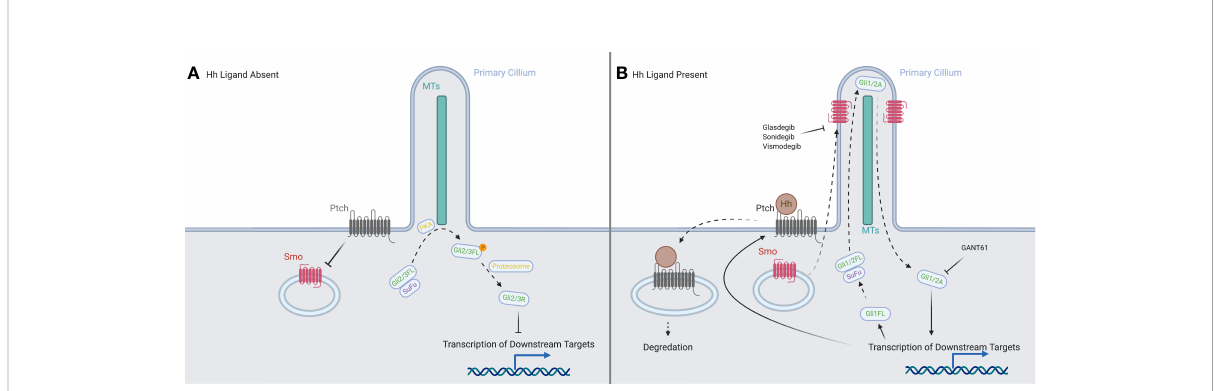
processed into their repressor forms, which inhibit downstream transcription. (B) When ligands are present, they are bound by PTCH and both are internalized and degraded. This allows the translocation of SMO to the tip of the primary cilium, where it processes the full-length forms